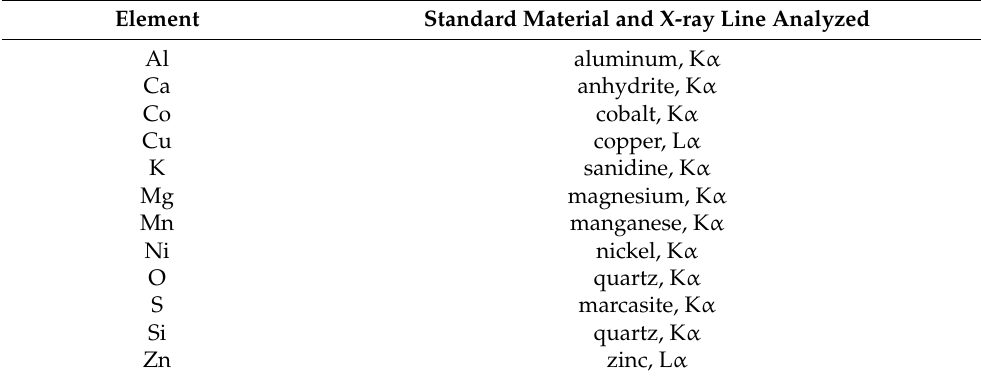
Table 2. The list of standards used in EDS analysis for concentration quantifications. Element